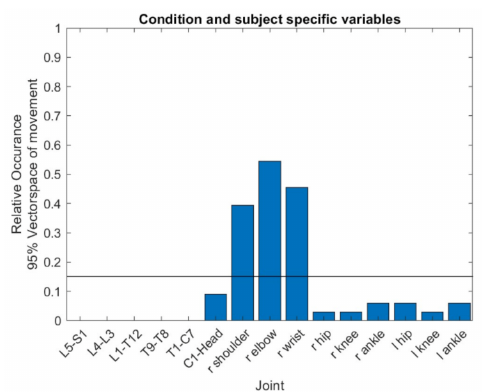
Figure 3. The relative frequencies of loadings in 15 joints beyond the limit of ± 0.045 of the Principal Component Analysis (PCA) to explain 95% of the motion variance (limit value of the relative frequencies at y = 5 / 33 = 0.1515).